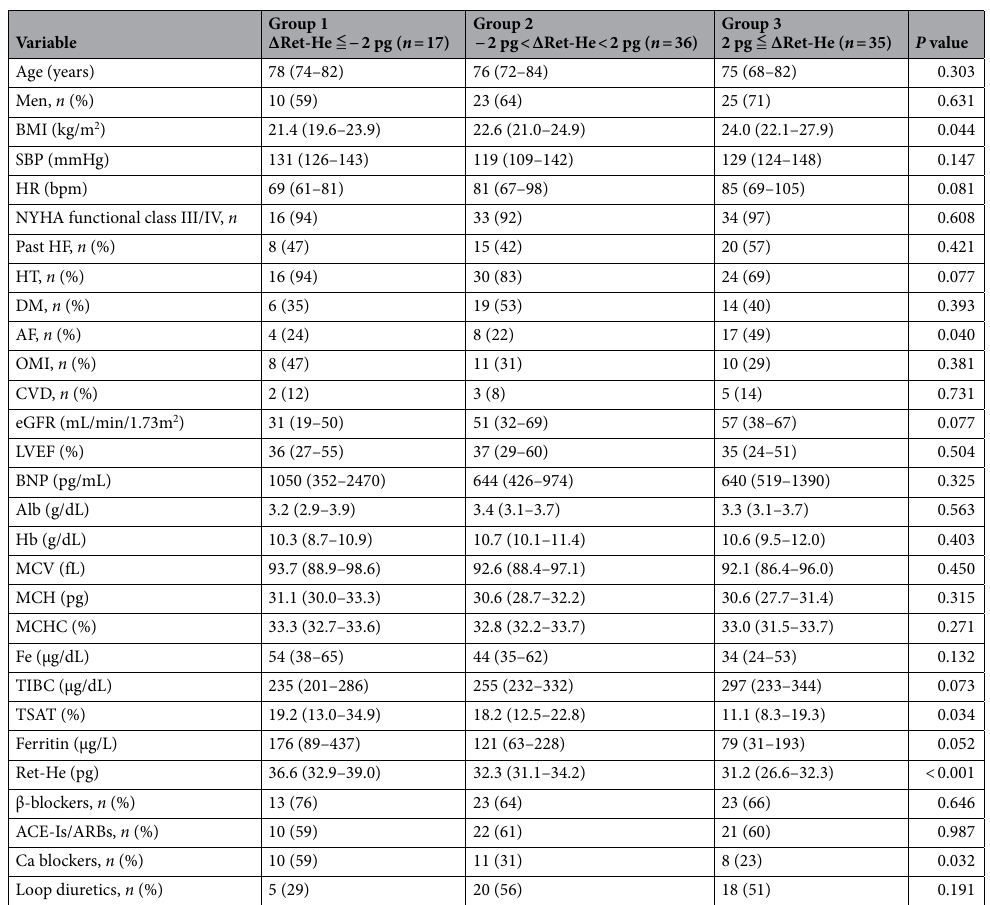
Table 2. Patient characteristics on admission according to a three-group classification of change in Ret-He levels between admission and discharge. Continuous variables are presented as median and interquartile range, and categorical variables are presented as number (percentage). ΔRet-He the change of Ret-He levels between admission and discharge, BMI body mass index, SBP systolic blood pressure, HR heart rate, Past HF past hospitalization for heart failure, HT hypertension, DM diabetes mellitus, AF atrial fibrillation, OMI old myocardial infarction, CVD cerebrovascular disease, eGFR estimated glomerular filtration rate, LVEF left ventricular ejection fraction, BNP brain natriuretic peptide, Alb albumin, Hb hemoglobin, MCV mean corpuscular volume, MCH mean corpuscular hemoglobin, MCHC mean corpuscular hemoglobin concentration, TIBC total iron binding capacity, TSAT transferrin saturation, Ret-He reticulocyte hemoglobin equivalent, ACE-I angiotensin-converting enzyme inhibitor, ARB angiotensin II receptor blocker.